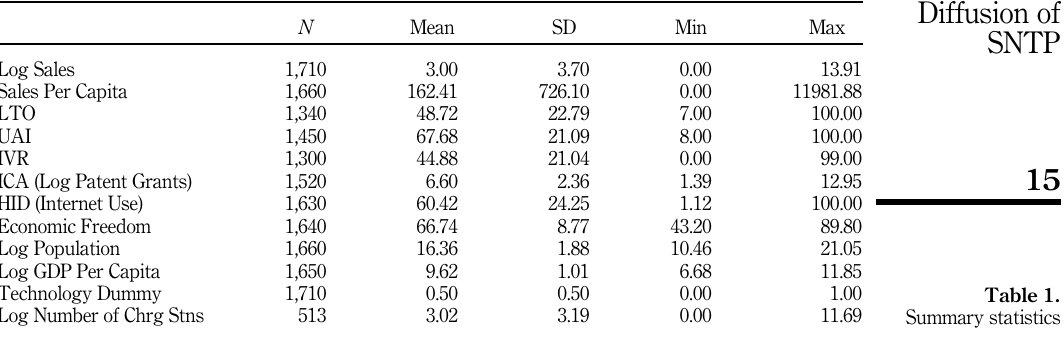
Table 1. Summary